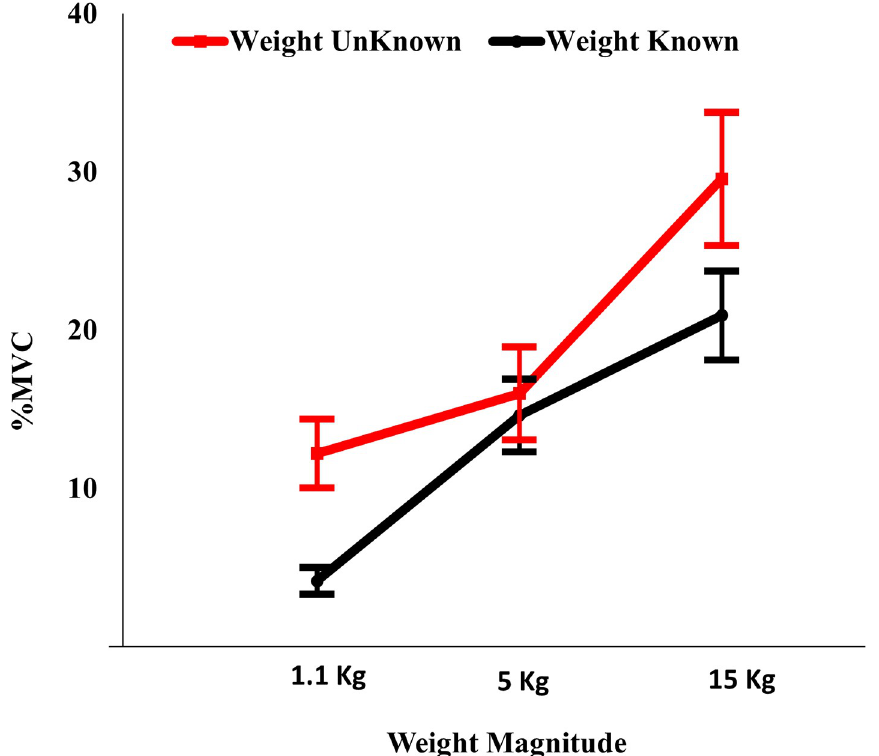
Fig 1. Effects of weight knowledge and weight magnitude on %MVC of trapezius